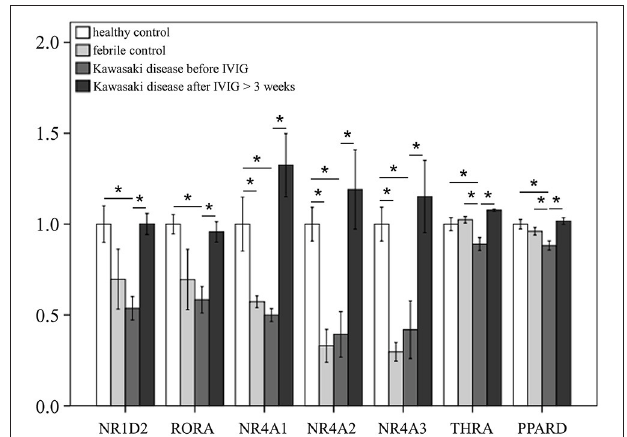
FIGURE 1 | mRNA expressions of steroid hormone receptors by GeneChip ® Human Transcriptome Array 2.0 between patients of Kawasaki disease (KD) and control subjects. Data are expressed as mean ± standard error for the three replications. *Significance ( p < 0.05).